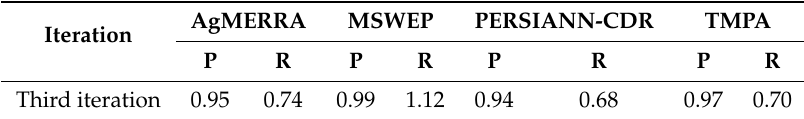
Table 6. P and R values of the third iteration